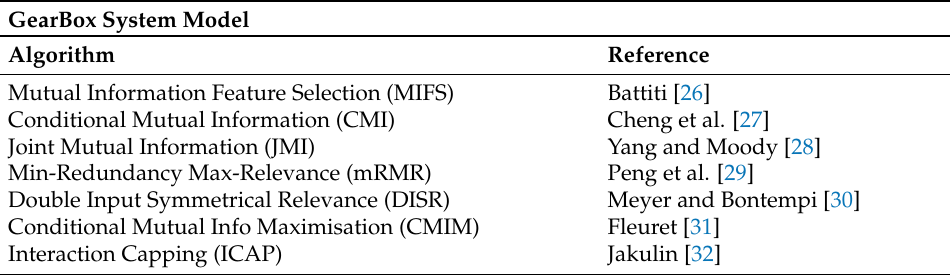
Table 3. Feature selection algorithms used in Reference [23] to identify the relevant variables, as an alternative to expert-based